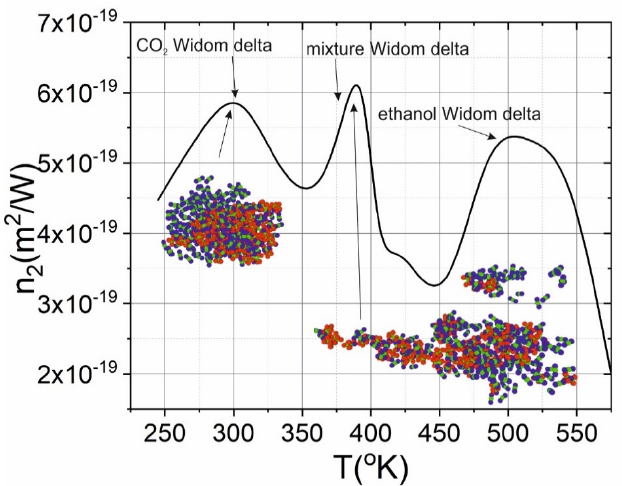
Figure 6. Dependence of nonlinear refractive index of CO 2 -ethanol mixture (3:1) at 80 bars. The insets show the molecular distribution.